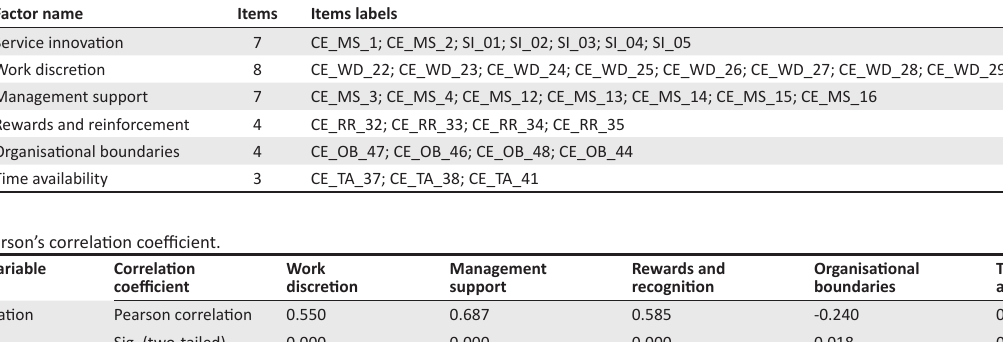
TABLE 3: Final factor definition.